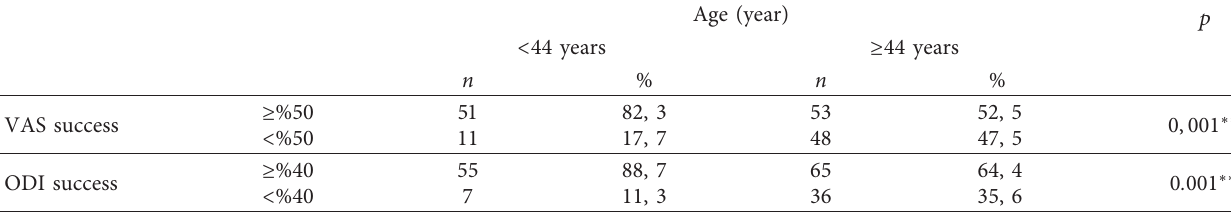
Table 4: Correlation between VAS and ODI success and age (cutoff value, 44).